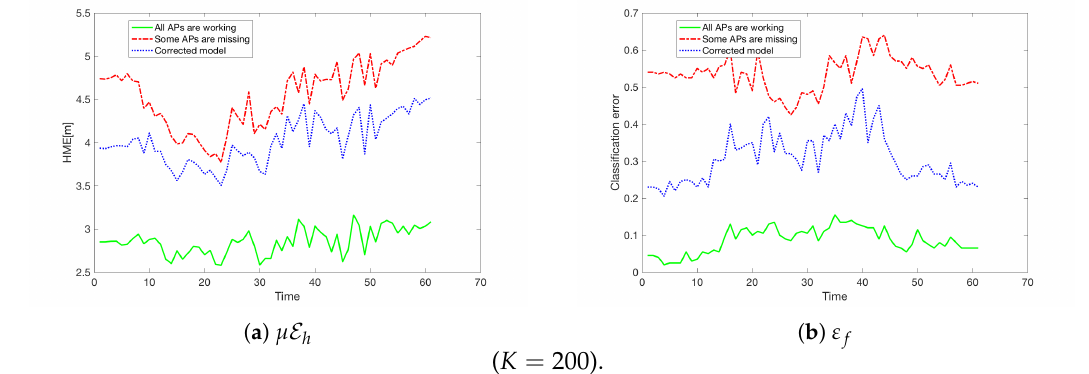
Figure 15. The results after the model was updated.